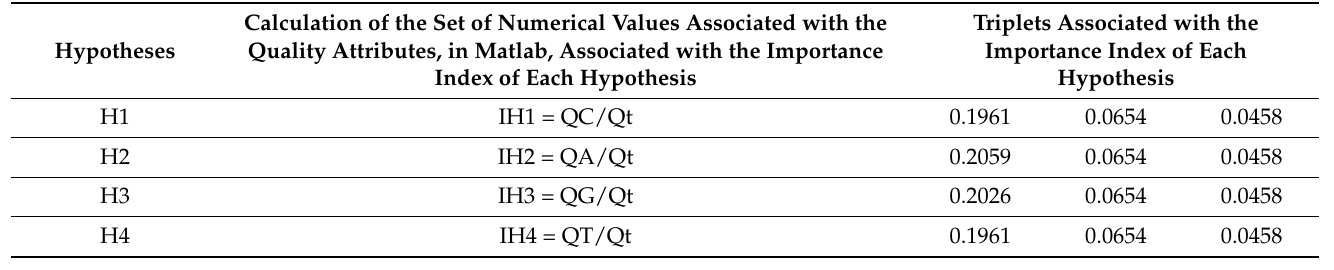
Table 4. Calculation of the triplets associated with the weight of the importance index of each hypothesis.